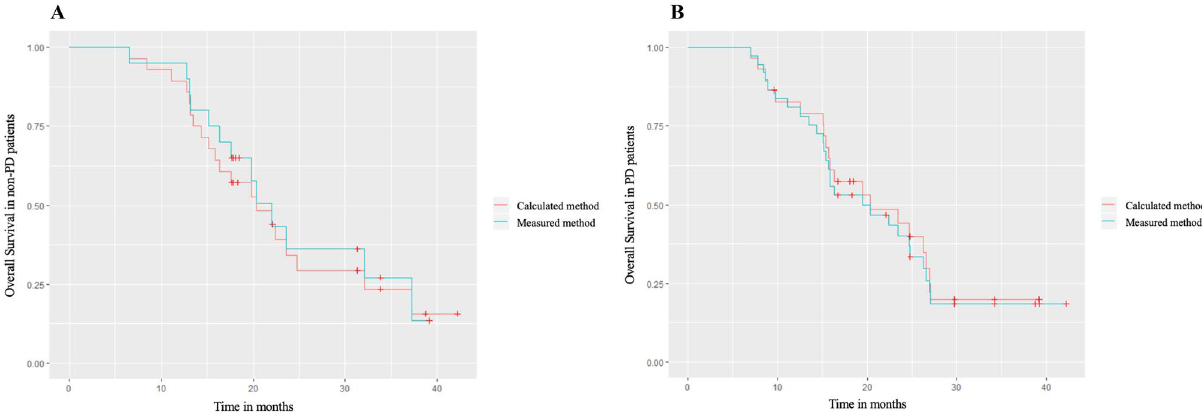
Figure 2. Overall survival according to the volume measurement methods. ( A ) Patients considered non-PD and ( B ) patients considered PD. OS overall survival, PD progressive